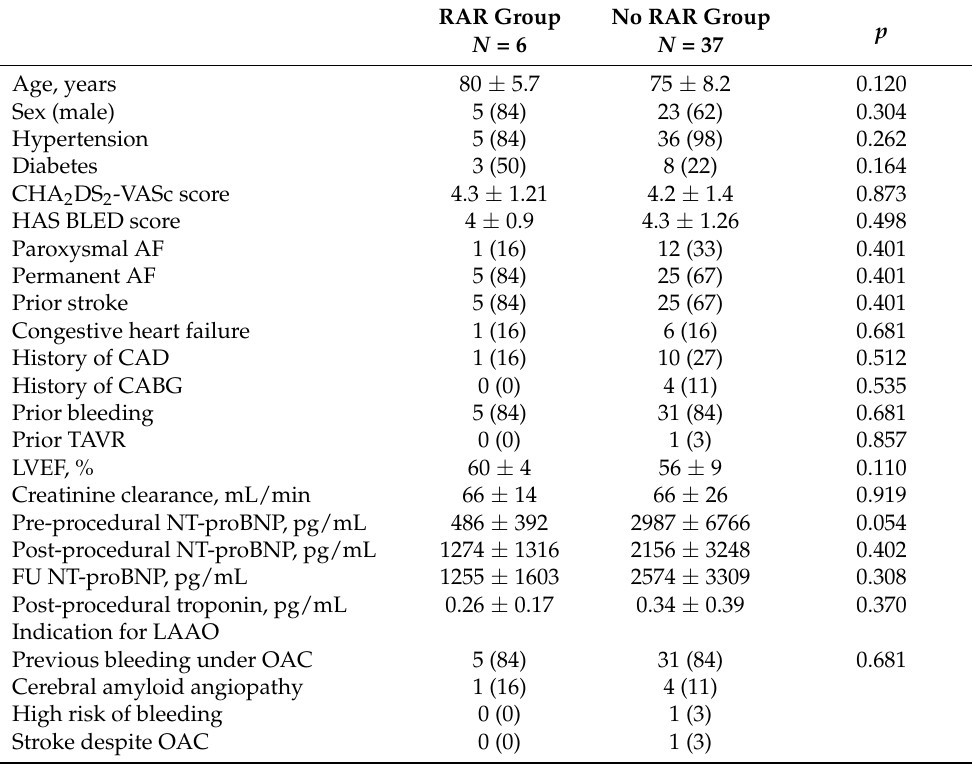
Table 1. Patients’ characteristics (according to the presence or absence of reverse atrial